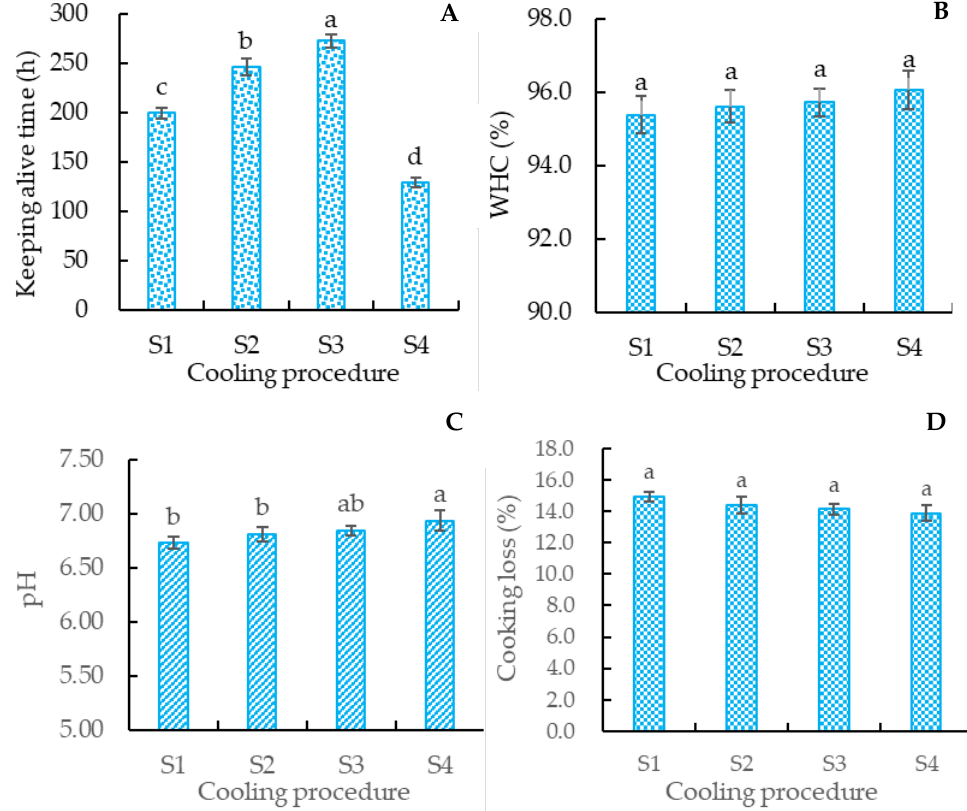
Figure 3. Effects of cooling speed on Keeping alive time, WHC, pH, and cooking loss of crucian carp meat. ( A ) Keeping alive time, ( B ) WHC, ( C ) pH, ( D ) cooking loss. S1: treated with cooling speed of 5 °C/h followed by 1 °C/h; S2: treated with cooling speed of 3 °C/h followed by 1 °C/h; S3: treated with cooling speed of 2 °C/h followed by 1 °C/h; S4: control. Different letters above the standard deviation represent significant differences between the groups ( p < 0.05).